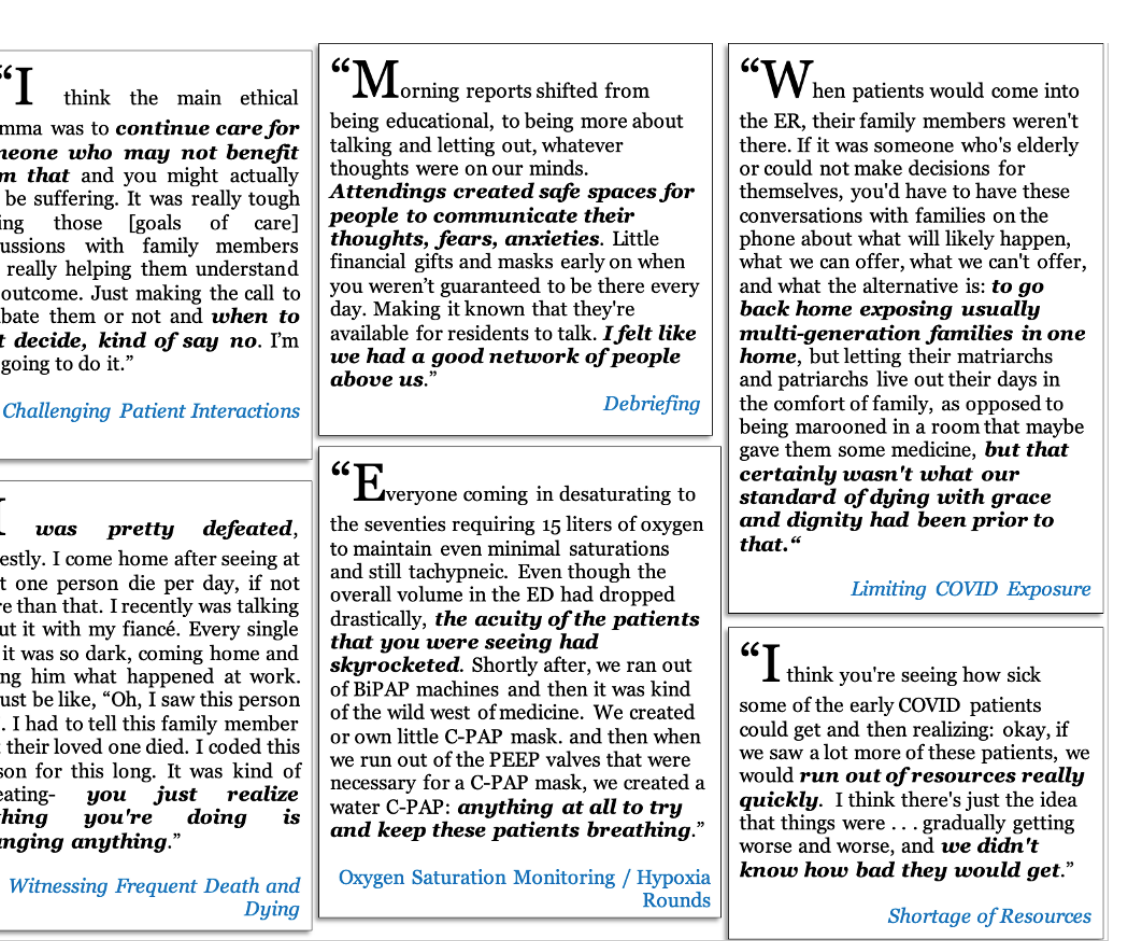
Figure 4. Quotations describing the workplace challenges and adaptive workplace strategies experienced by 25 emergency medicine resident physicians when working and training during the first wave of the COVID-19 pandemic in two urban US hospitals, 2020. COVID-19, coronavirus disease 2019; US, United